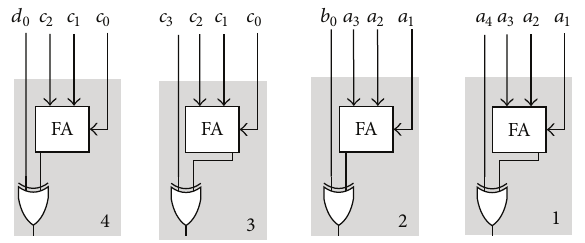
Figure 5: Boolean network for (1, 4, 1, 5; 5) GPC with no carry logic.